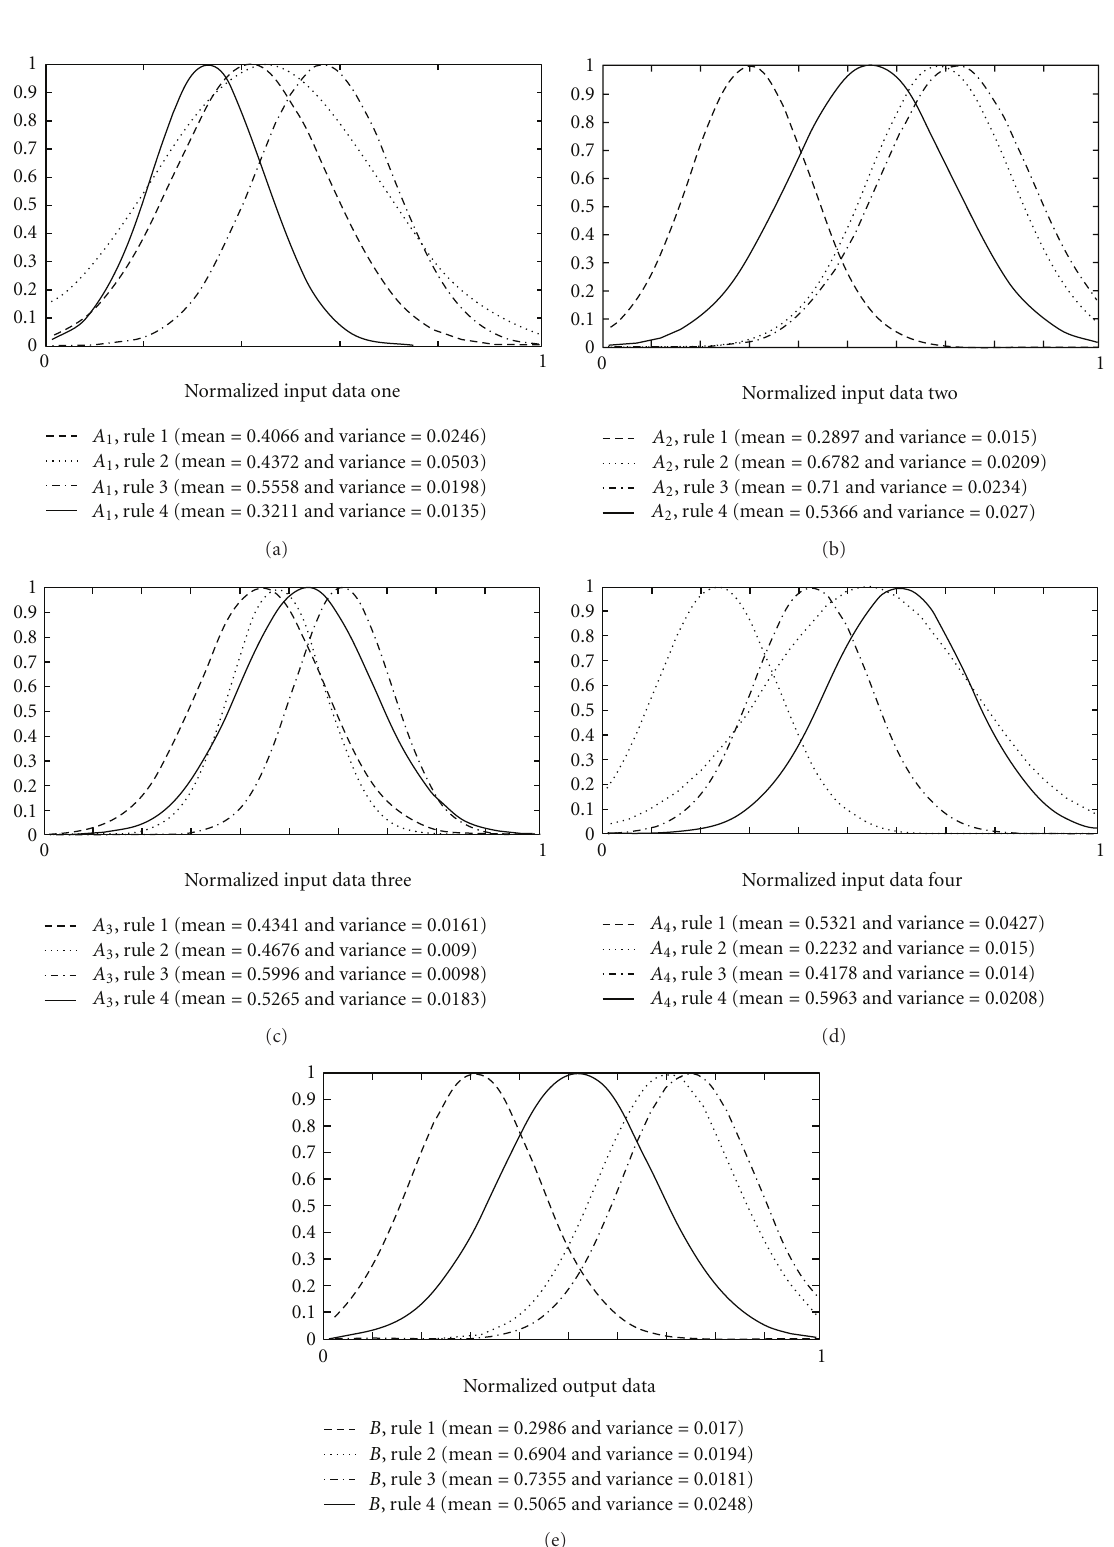
Figure 3: (a) Membership function for input one. (b) Membership functions for input two. (c) Membership function for input three. (d) Membership function for input four. (e) Membership function for